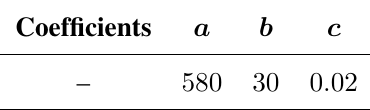
Table 8. Error characteristic’s